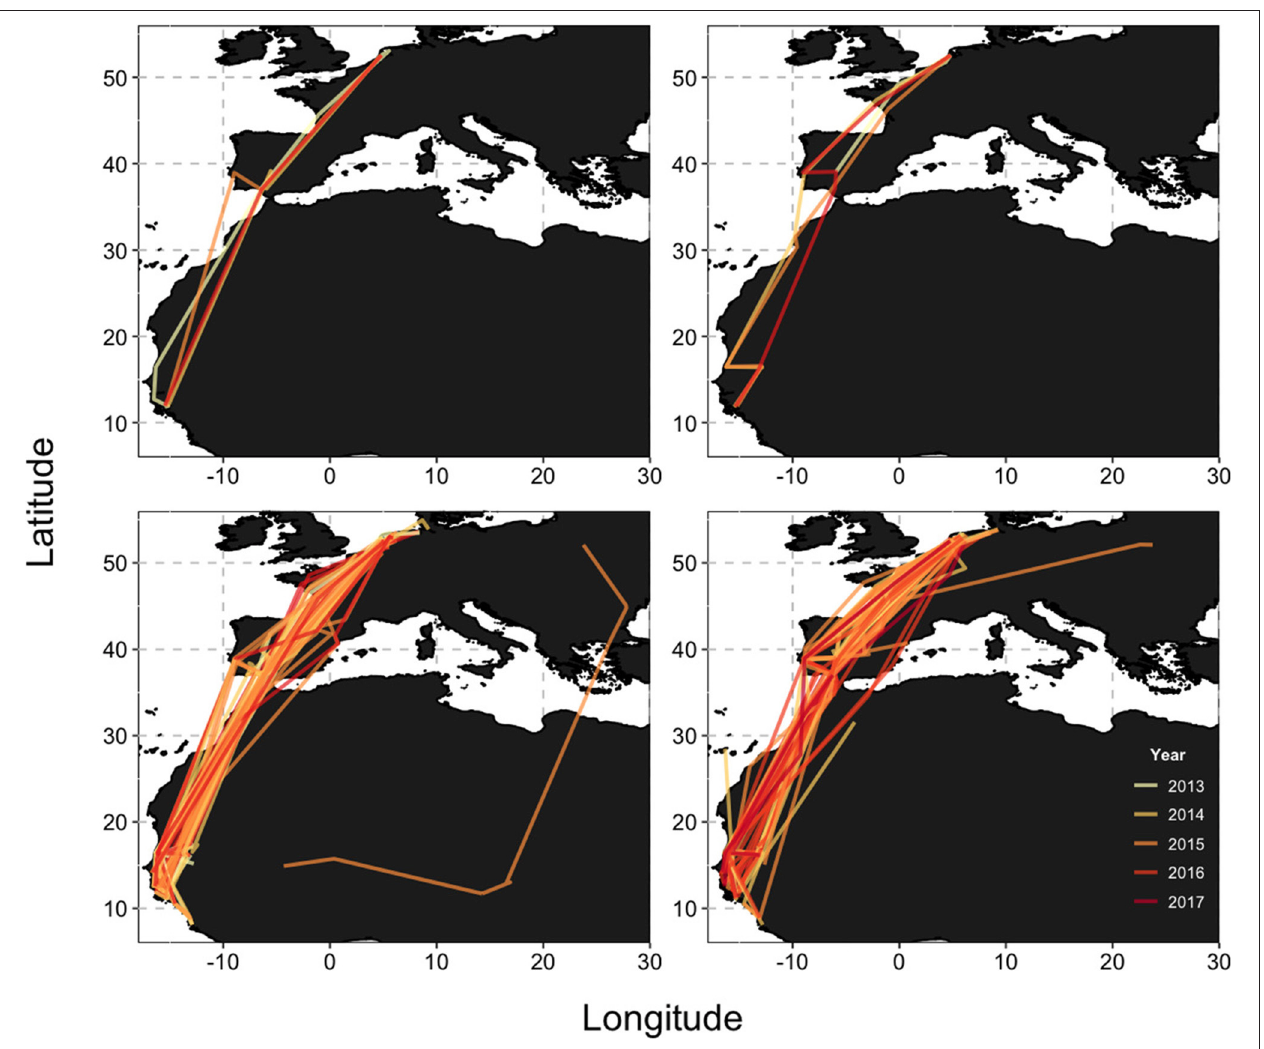
FIGURE 1 | The migratory routes during southward (left) and northward (right) migrations for the entire tracked population (bottom; n = 57 individuals), as well as a representative individual, “Badajoz,” (top; n = 4 years). The legend applies to all panels.